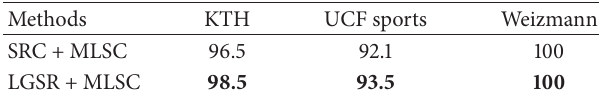
Table 3: Comparison results between LGSR and SRC (UNIT: